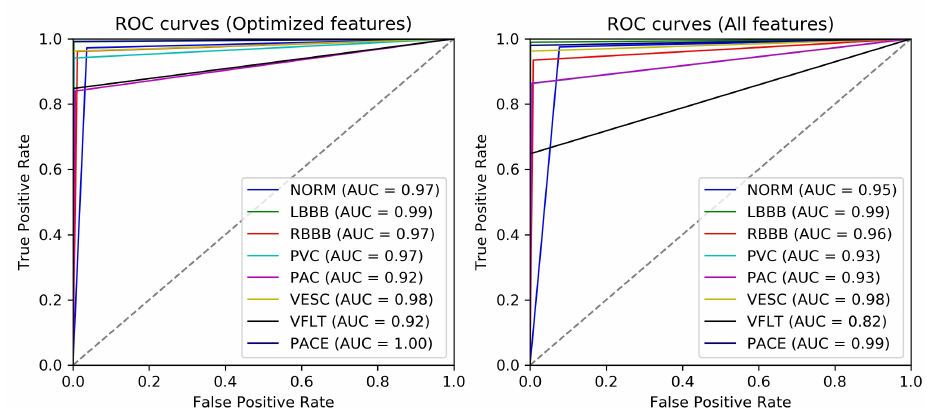
Figure 7. ROC curves of 8 classes for Optimized feature subset (left panel) and All feature set (right